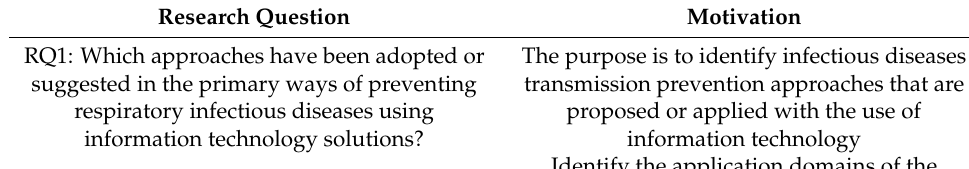
Table 1. Proposed research questions